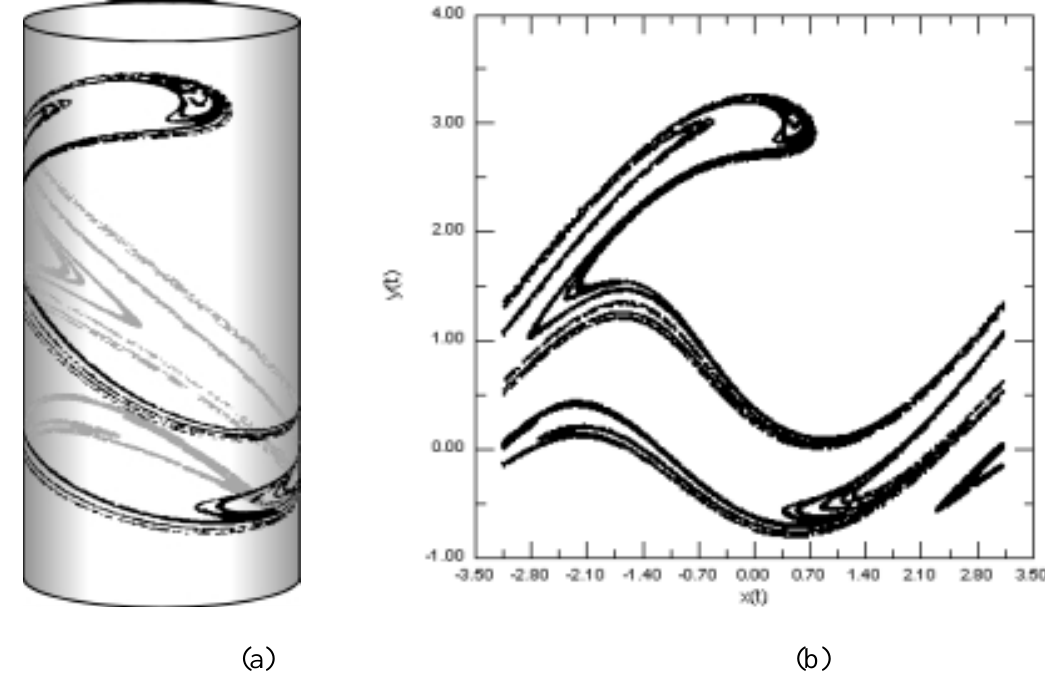
Fig. 2. Strange attractor. (a) Cylindrical phase space; (b) Plane phase